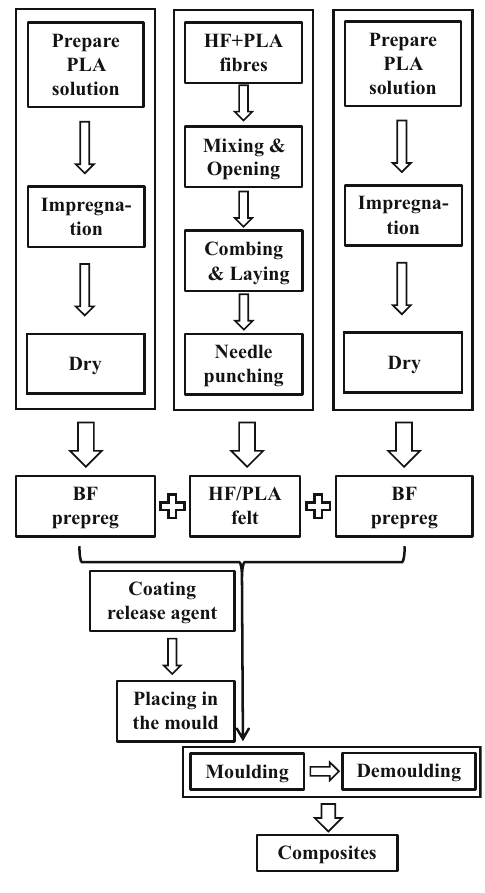
Figure 2: The manufacturing process of composites ( conceptual diagram )